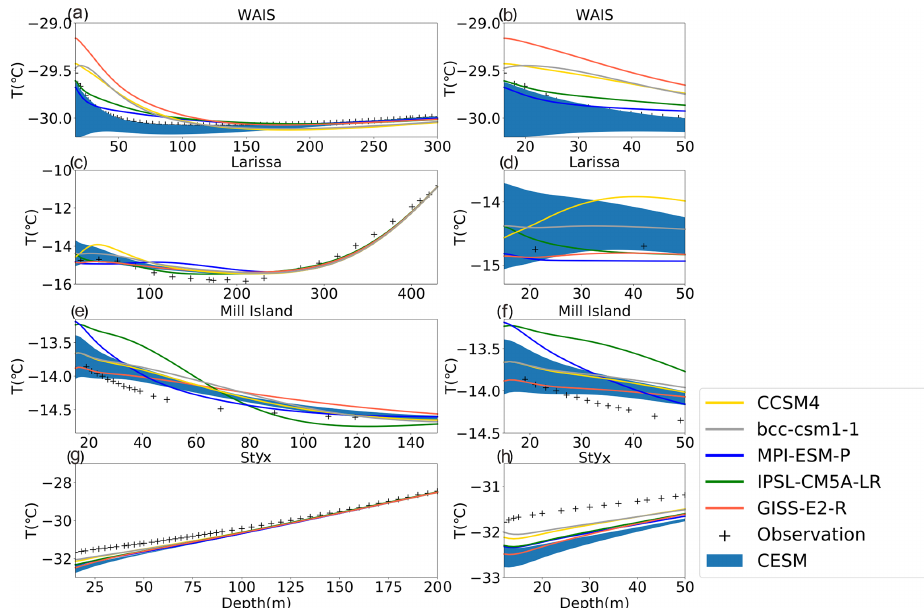
Figure 5. Comparisons between simulated subsurface temperature and measurements for the following: (a) WAIS: 15–300m; (b) WAIS: 15–50m; (c) Larissa: 15–430m; (d) Larissa: 15–50m; (e) Mill Island: 15–150m; (f) Mill Island: 15–50m; (g) Styx: 15–200m; and (h) Styx: 15–50m. The shaded area represents the simulated subsurface temperature ensemble driven by CESM ensemble. The right column is a zoom over the upper 50m for each